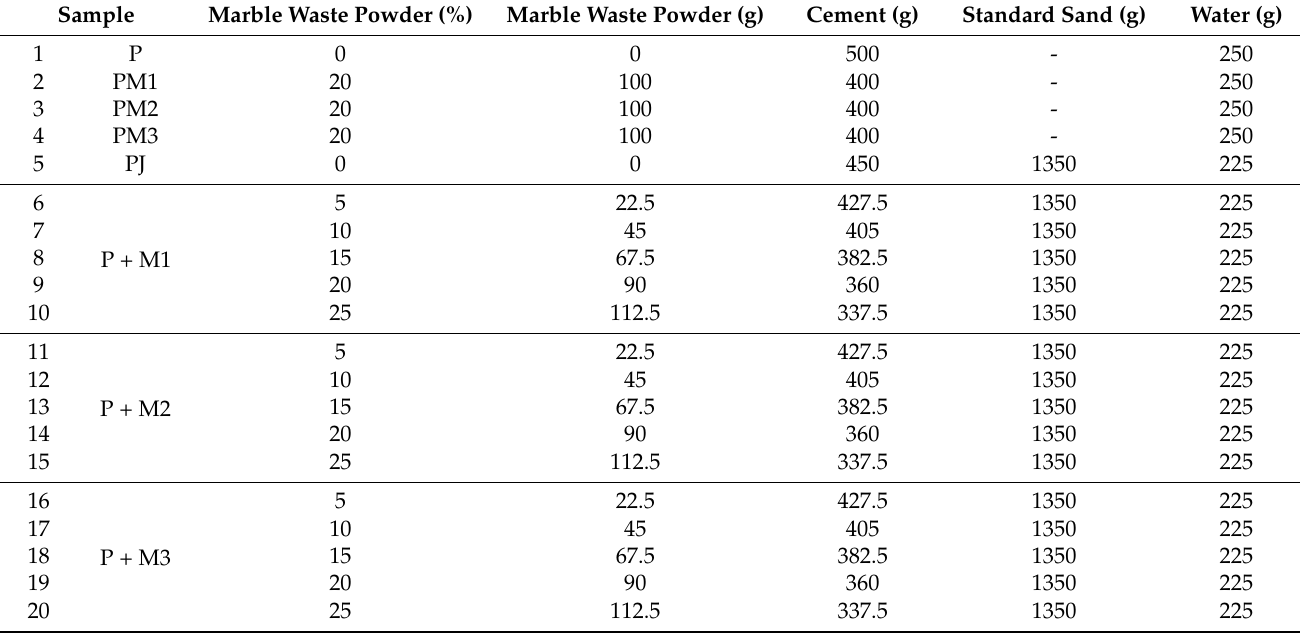
Table 3. Test mix